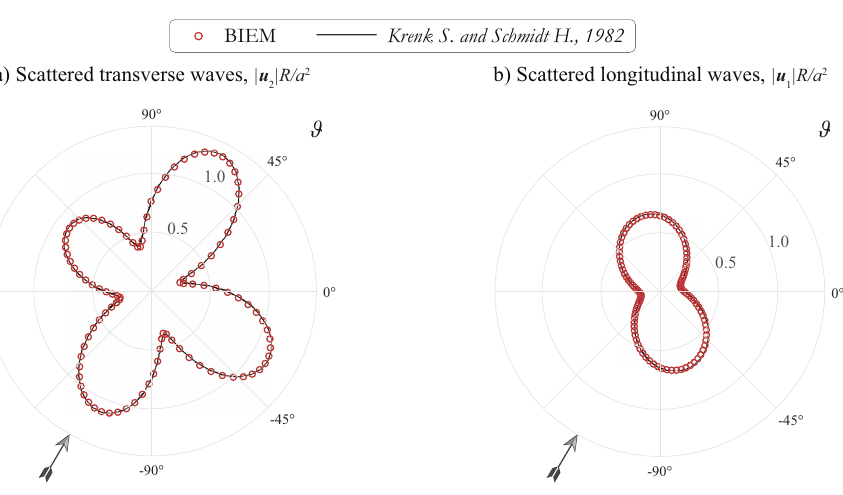
Figure 3. Amplitudes of the COD | ∆ u | of an open circular crack in the elastic space with Poisson’s ratio ν = 0.25 for the normally incident longitudinal wave at k T 2 a = 10: comparison with [29].